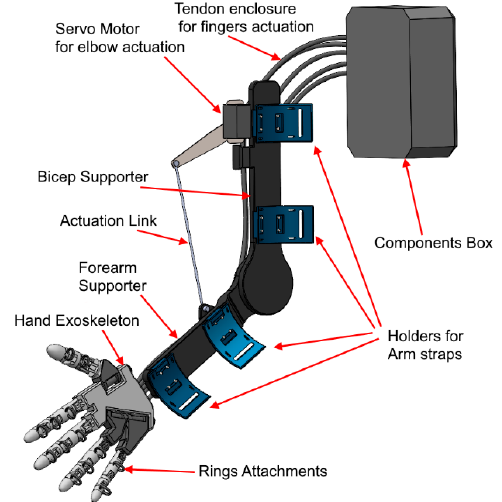
Figure 8. Design of the exoskeleton.